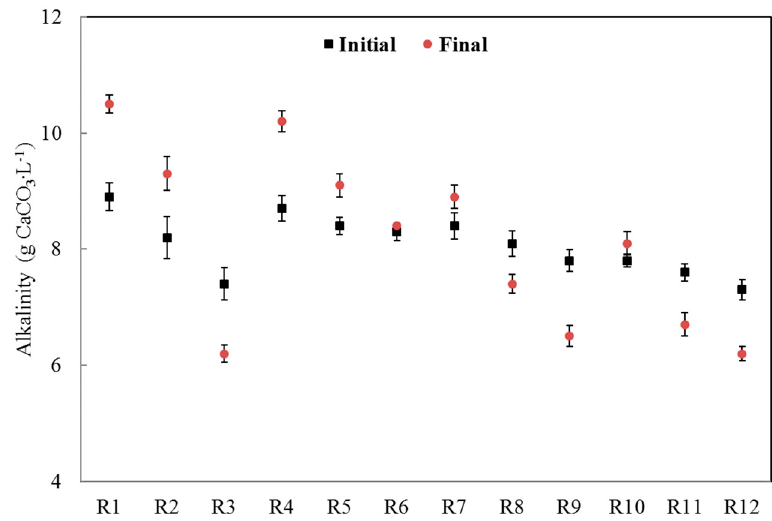
Figure 4. Alkalinity for reactors treating PFSF inoculated with three different inoculums and their mixtures.